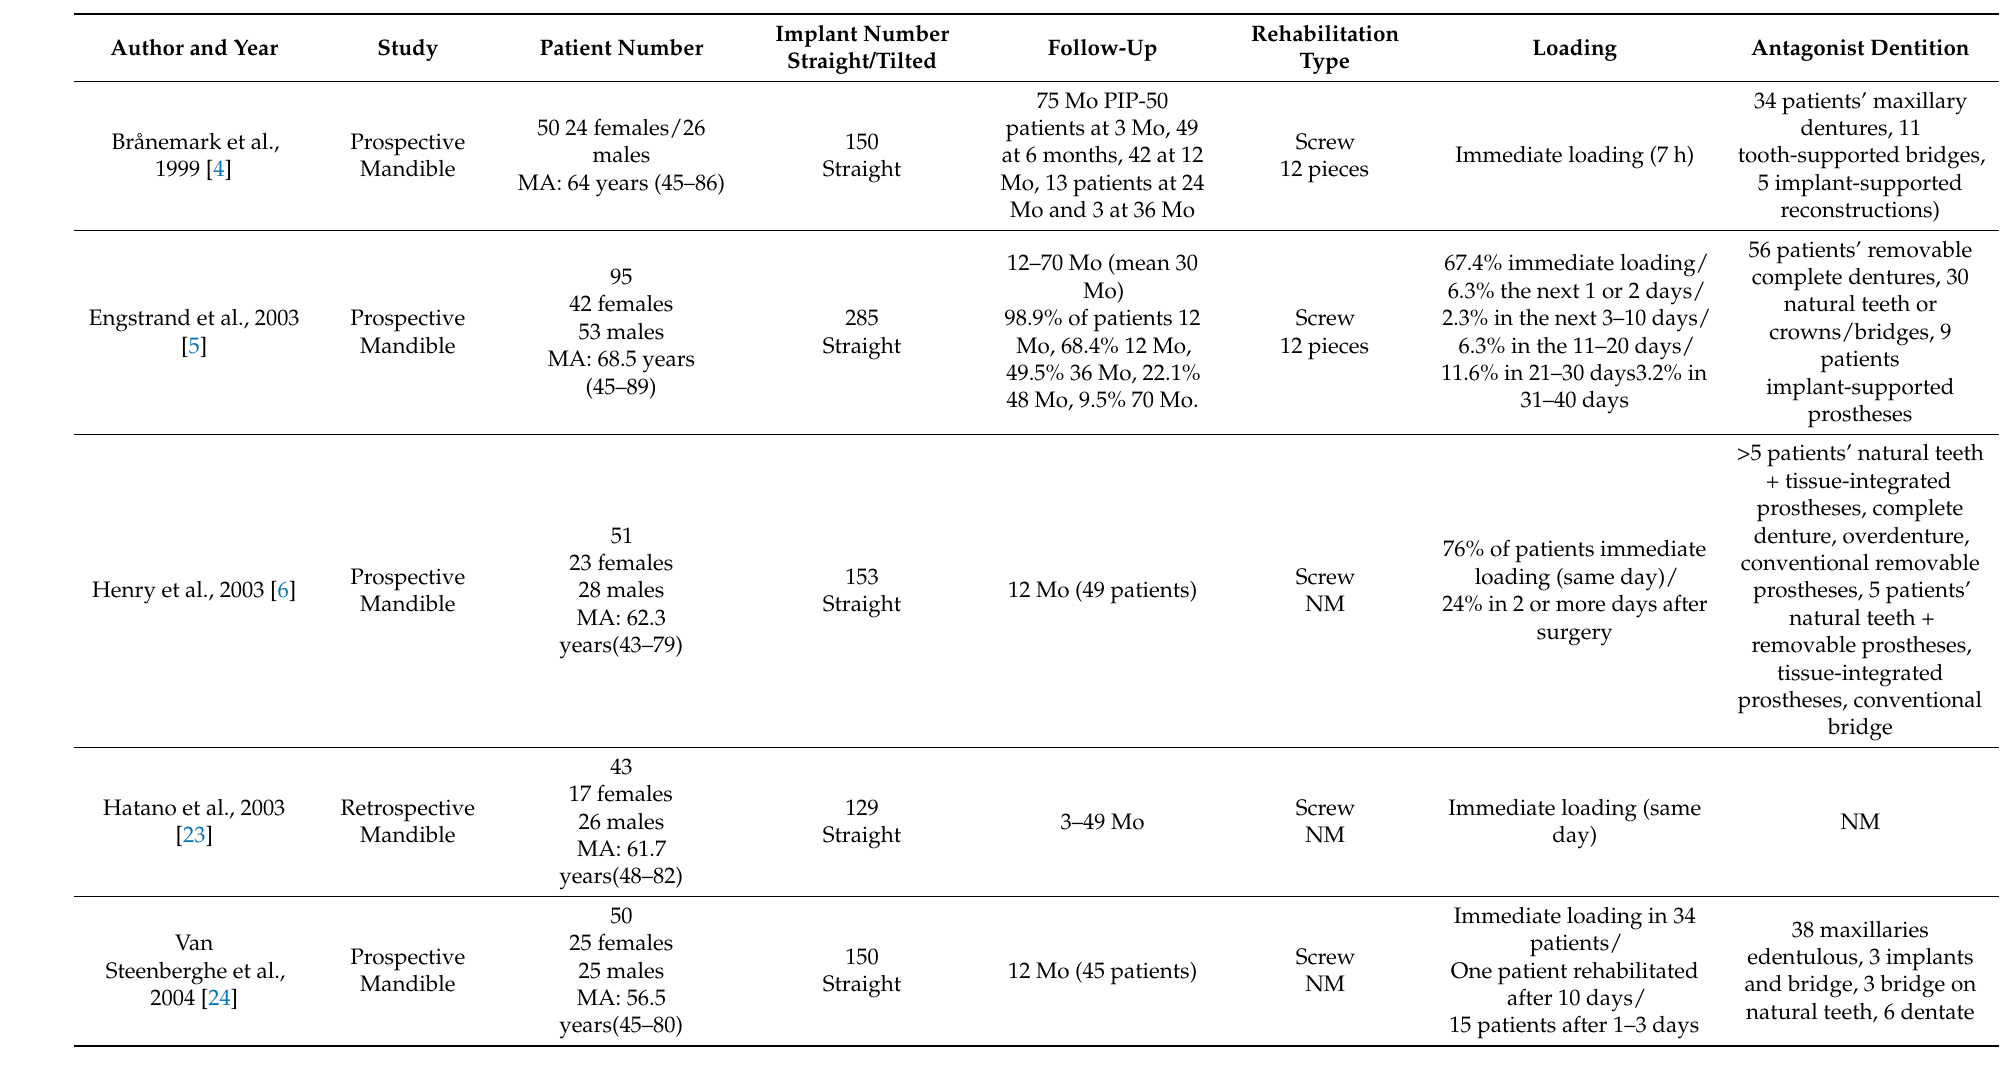
Table 1. Information about studies reviewed, evaluating ISFCDPs on 3 dental implants: study type, sample size, implant survival rate, follow-up, rehabilitation type,